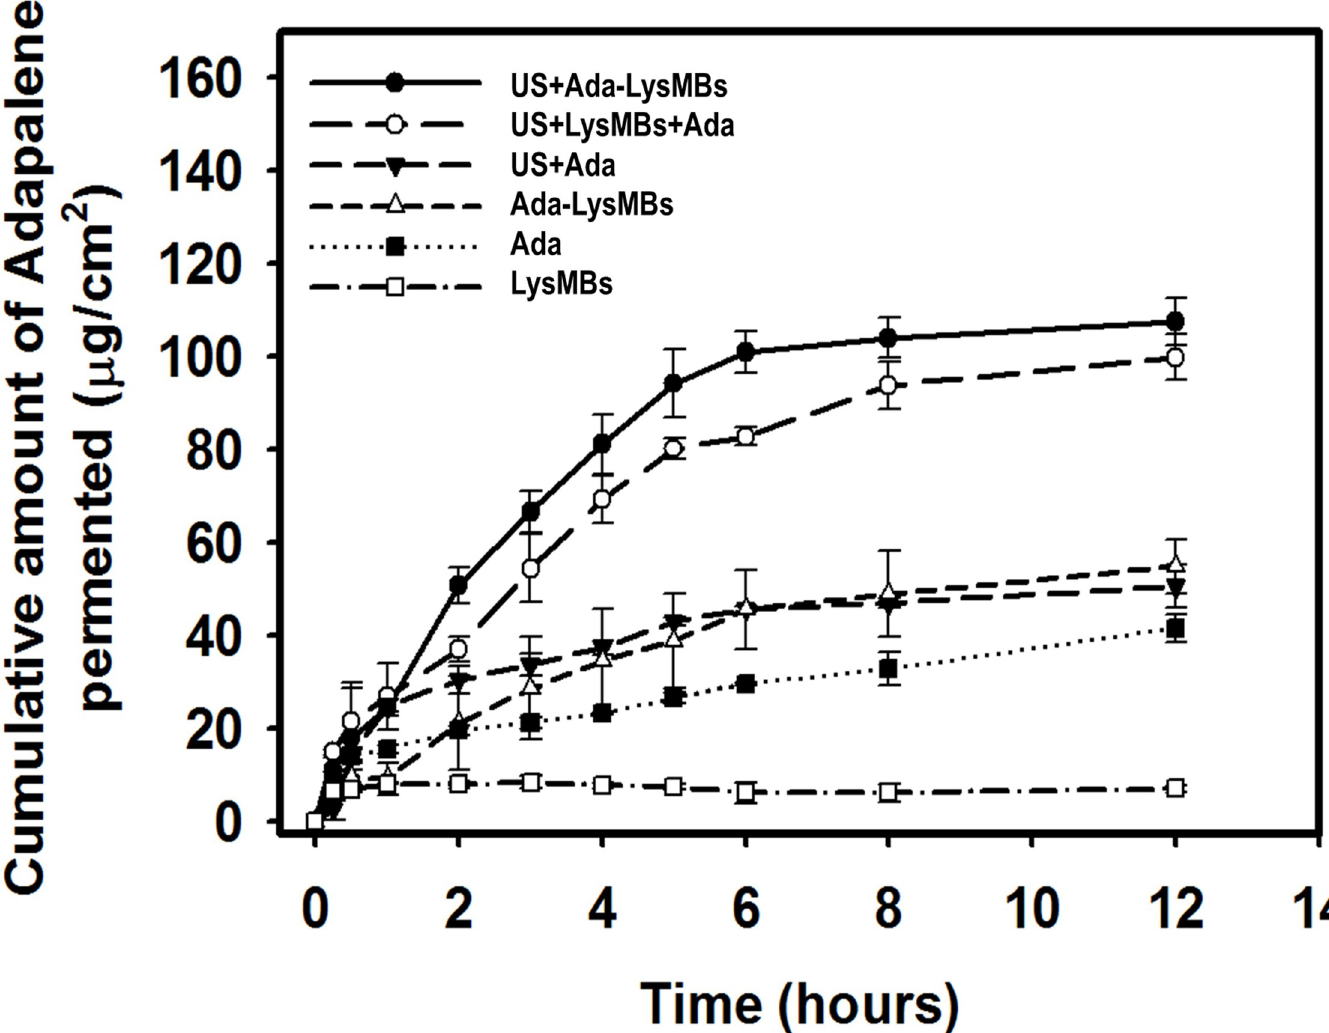
Fig 7. Percutaneous penetration of Ada in isolated skin treated as indicated for 12 h analyzed using a UV-visible spectrophotometer. Data represent the mean values and standard deviations.